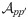
Tree representation of reassortment.(a) Representation of reassortment in a two-segment genealogical tree. The parent strains p and p′ are in different sublineages of the tree; the reassortant strain r appears as a descendant of one of these parents (here p′; there is an equivalent tree in which r appears as a descendant of p). The strains p, p′, and r are the focal nodes of the clades Cp, Cp′, and Cr, respectively (grey areas). We identify the reassortment event by its set of core mutations, App′, which appear on the segment that r inherits from p and generate the genetic distance between the parent strains in that segment. The core mutations appear on the branches between the nodes p and p′ (filled red triangles: mutations between p and the last common ancestor a, filled purple triangles: mutations between a and p′). Their reverse mutations appear on the branch between p′ and r (empty red and purple triangles), which can also contain additional mutations (grey triangles). (b) A true event (nr 1 in S2 Table) detected by our algorithm on the joint HA-NA tree. Each mutation on HA segment is labeled with a number between 1 and 1701 that indicates the site. The pattern of repeated and reversed mutations (filled and empty triangles) follows the scheme in Fig. 2a: the reassortant strain A/Hong Kong/CUHK33677/2004 is generated by an event with δ = 9 between p and p′ clades. (c) The result of a simulated reassortment event on the reconstructed genealogical tree, correctly detected by the algorithm. The internal node r is inferred as the reassortant ancestor of r1/2,s, i.e. the strains evolved from the sequence that was actually generated by reassortment between ps and ps′.